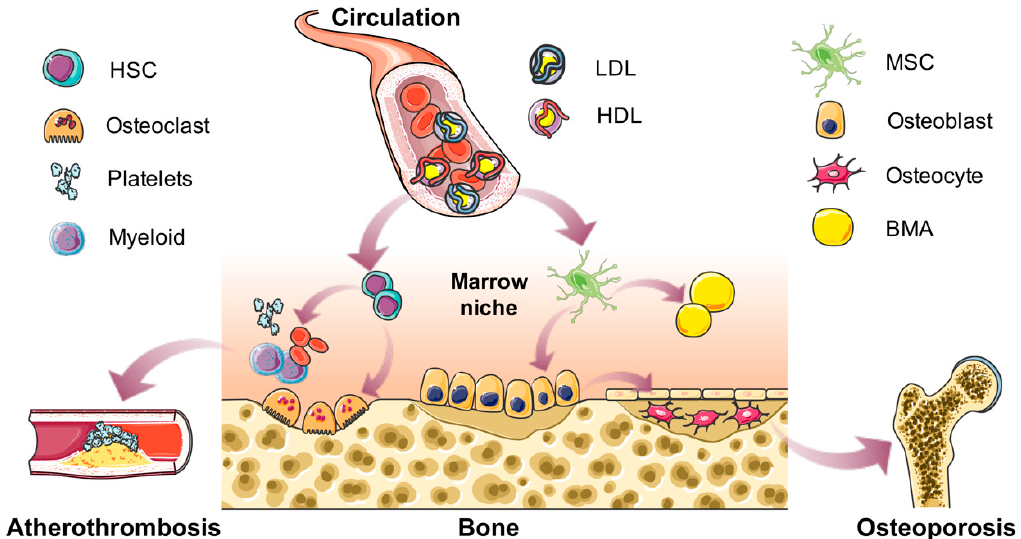
Figure 1. Summary of the effects of cholesterol on bone and marrow niche homeostasis. In the circulation, cholesterol is present in the forms of high-density lipoprotein (HDL), low-density lipoprotein (LDL), and very-low-density lipoprotein (VLDL) with lipoproteins. Normal concentrations of cholesterol are essential for the body. However, when the circulating concentration changes, it may become a risk factor. This review focuses on the roles of cholesterol in bone metabolism and bone marrow nice homeostasis. Cholesterol could drive the differentiation of marrow stromal cells (MSCs) into either osteoblasts or bone marrow adipocytes (BMAs), and further influence the bone mass or osteoporosis. Meanwhile, cholesterol affects the proliferation and mobilization of hematopoietic stem cells (HSCs), myeloid lineage differentiation and thrombocytosis, effects of which may potentially contribute to the development of atherothrombosis.